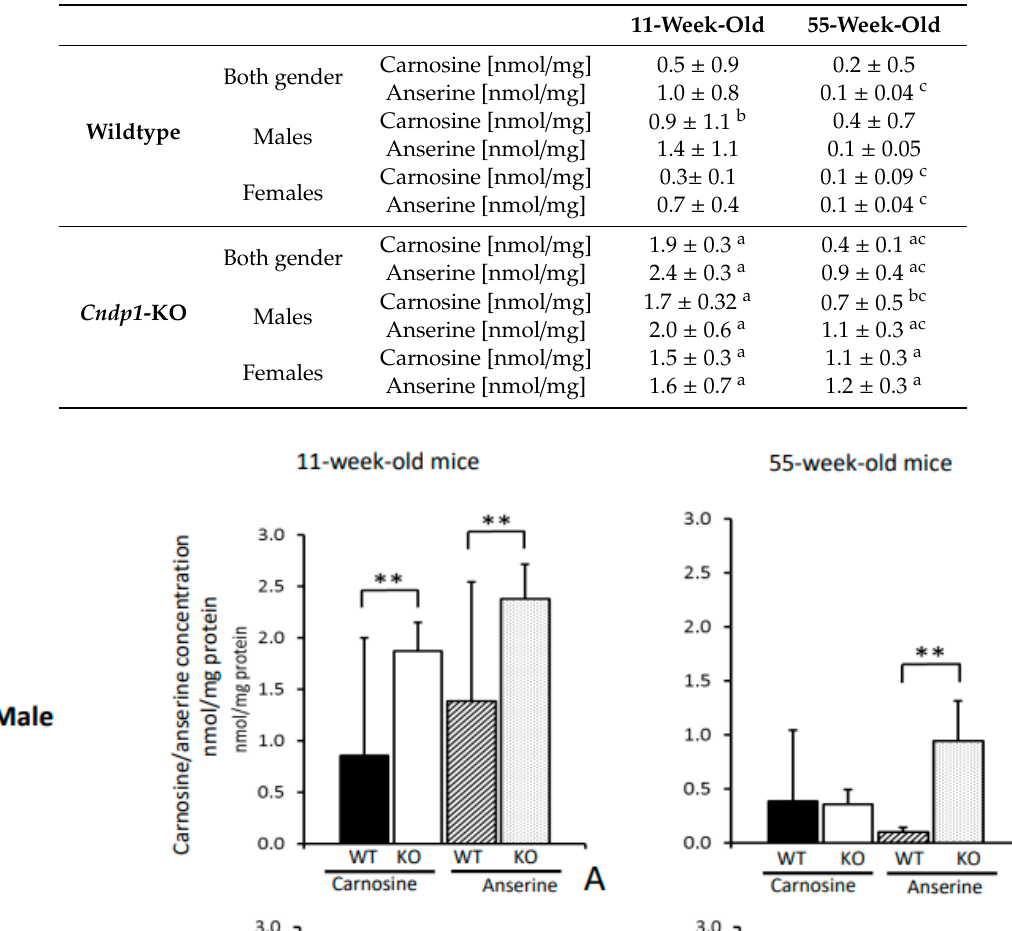
Table 2. Carnosine and anserine concentrations in kidney of 11- and 55-week-old Cndp1 -knockout ( Cndp1 -KO) and wildtype (WT) mice ( n = 4 for each group: WT male/female; Cndp1-KO male/female for both age groups). Significant differences ( p ≤ 0.05) are indicated by: a = Cndp1 -KO vs. WT; b = male vs. female; c = 55 vs. 11 weeks.